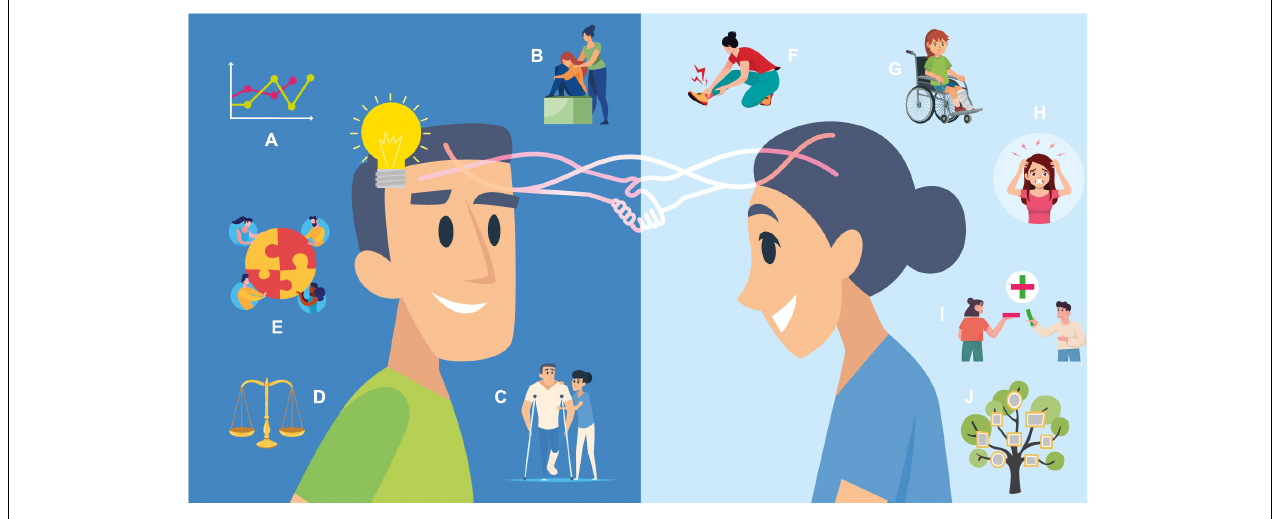
FIGURE 2 | Therapeutic alliance as active inference. (A) Opportunity to build a synchronous relationship and understanding of the injury. (B) Opportunity to show empathy to reduce anxiety and fears. (C) Working together to create a therapeutic alliance for recovery. (D) Regulating disrupted allostasis. (E) Joint attention to regulate allostasis and support recovery. (F) Injury and pain—“what have I done?” (G) Fears of what the injury will become. (H) Anxiety over the injury. (I) The hope of collaborative communication to understand and create a treatment and management plan. (J) Previous priors surrounding the injury including injury beliefs, social expectations, family and injury